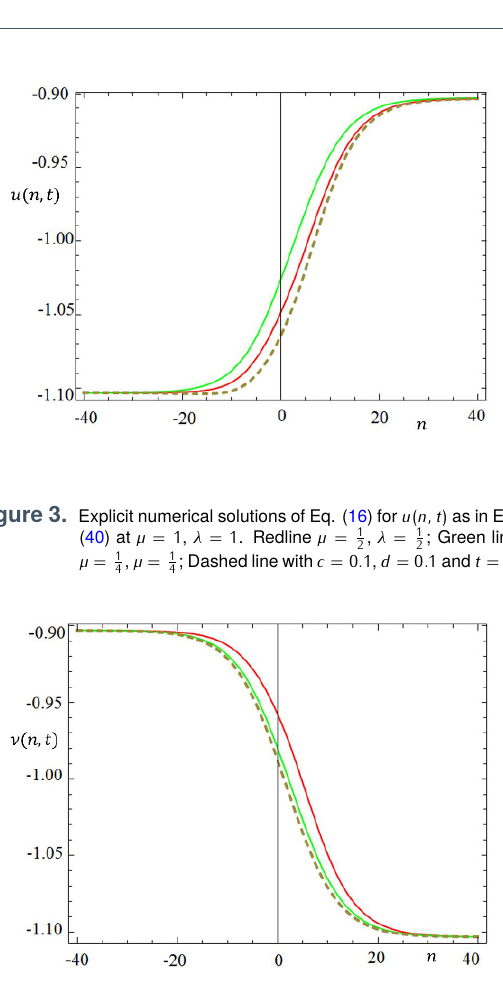
( n,t ) as in Eq. , β = 1 ; Green line 2 2